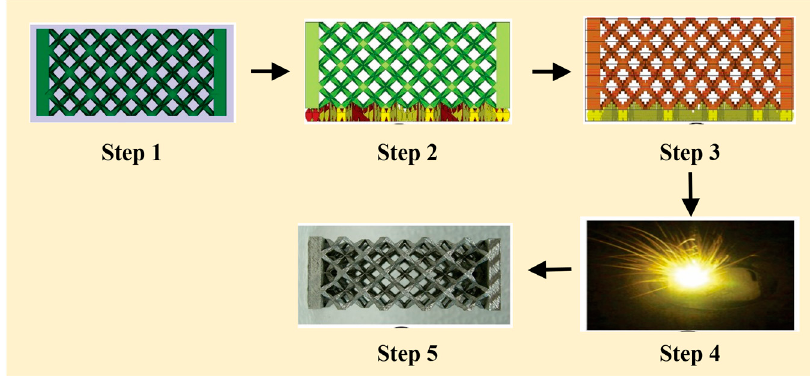
Figure 1. Schematic process chain of the selective laser melting process; step 1: production of a CAD file; step 2: part orientation and support structure generation; step 3: slicing of the part and applying the process parameters; step 4: selective melting of the powder bed; and step 5: removal of the support structure to receive the finished part.